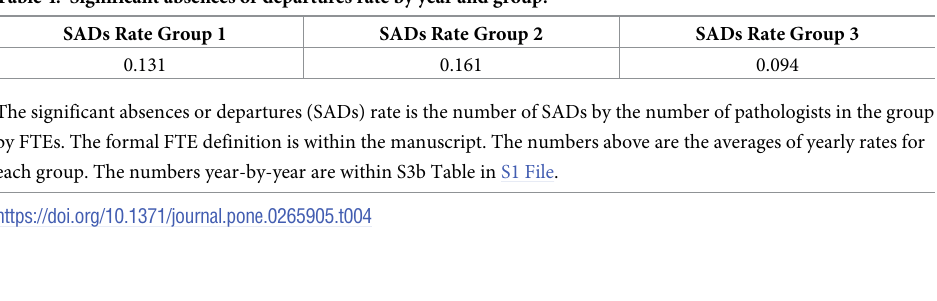
Table 4. Significant absences or departures rate by year and